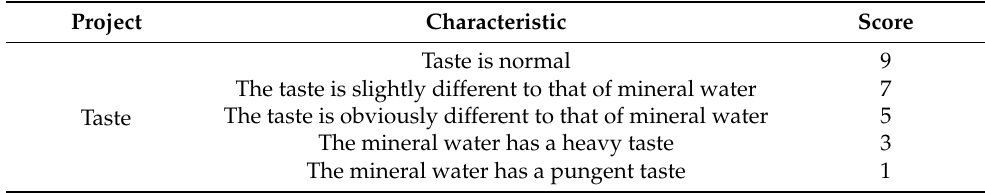
Table 1. The sensory index scoring criteria of antioxidant active plastic bottle